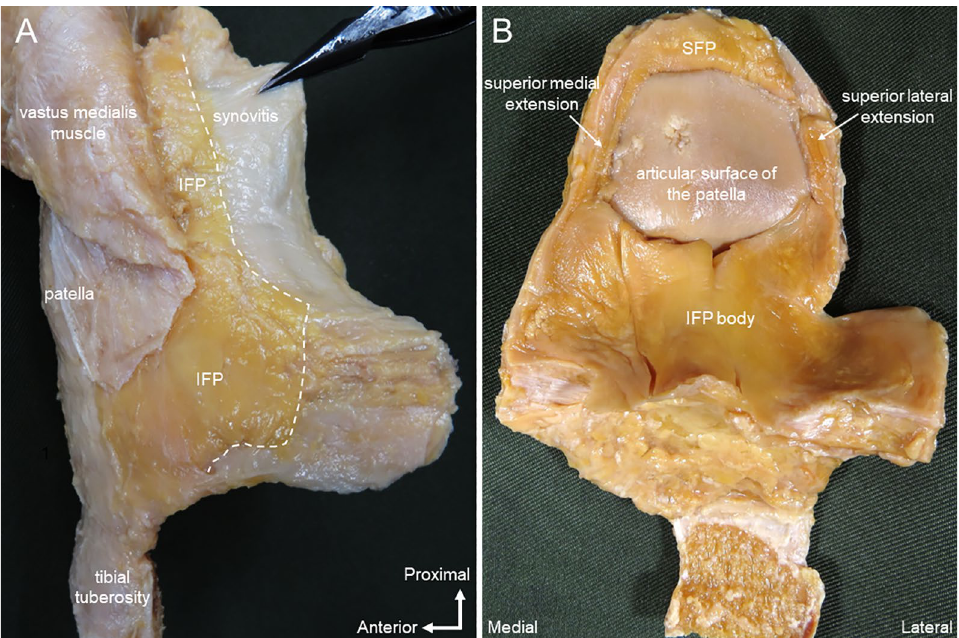
Figure 3. Method for dissection of the infrapatellar fat pad; right knee. ( A ) Medial view. The vastus medialis muscle is flipped forward and the synovium is gripped with forceps. An incision is made along the white dashed line to remove synovium not adherent to the infrapatellar fat pad. ( B ) Posterior view. The quadriceps femoris is removed along the morphology of the infrapatellar fat. IFP infrapatellar fat pad, SFP suprapatellar fat pad. White dashed line: boundary between Infrapatellar fat pad and